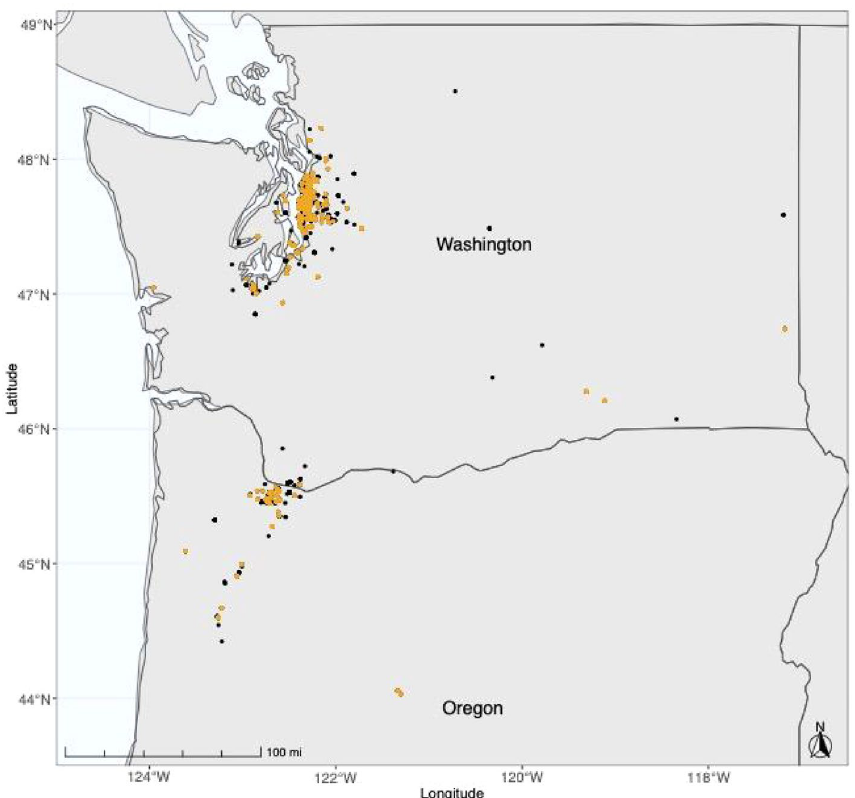
Figure 1. Map of study area, which includes the states of Washington and Oregon. Dots mark the locations of all monitoring sites included in our analysis. We had information on supplementary resources (i.e., availability of bird feeders and bird baths) for monitoring sites shown in orange. Map created using R 51